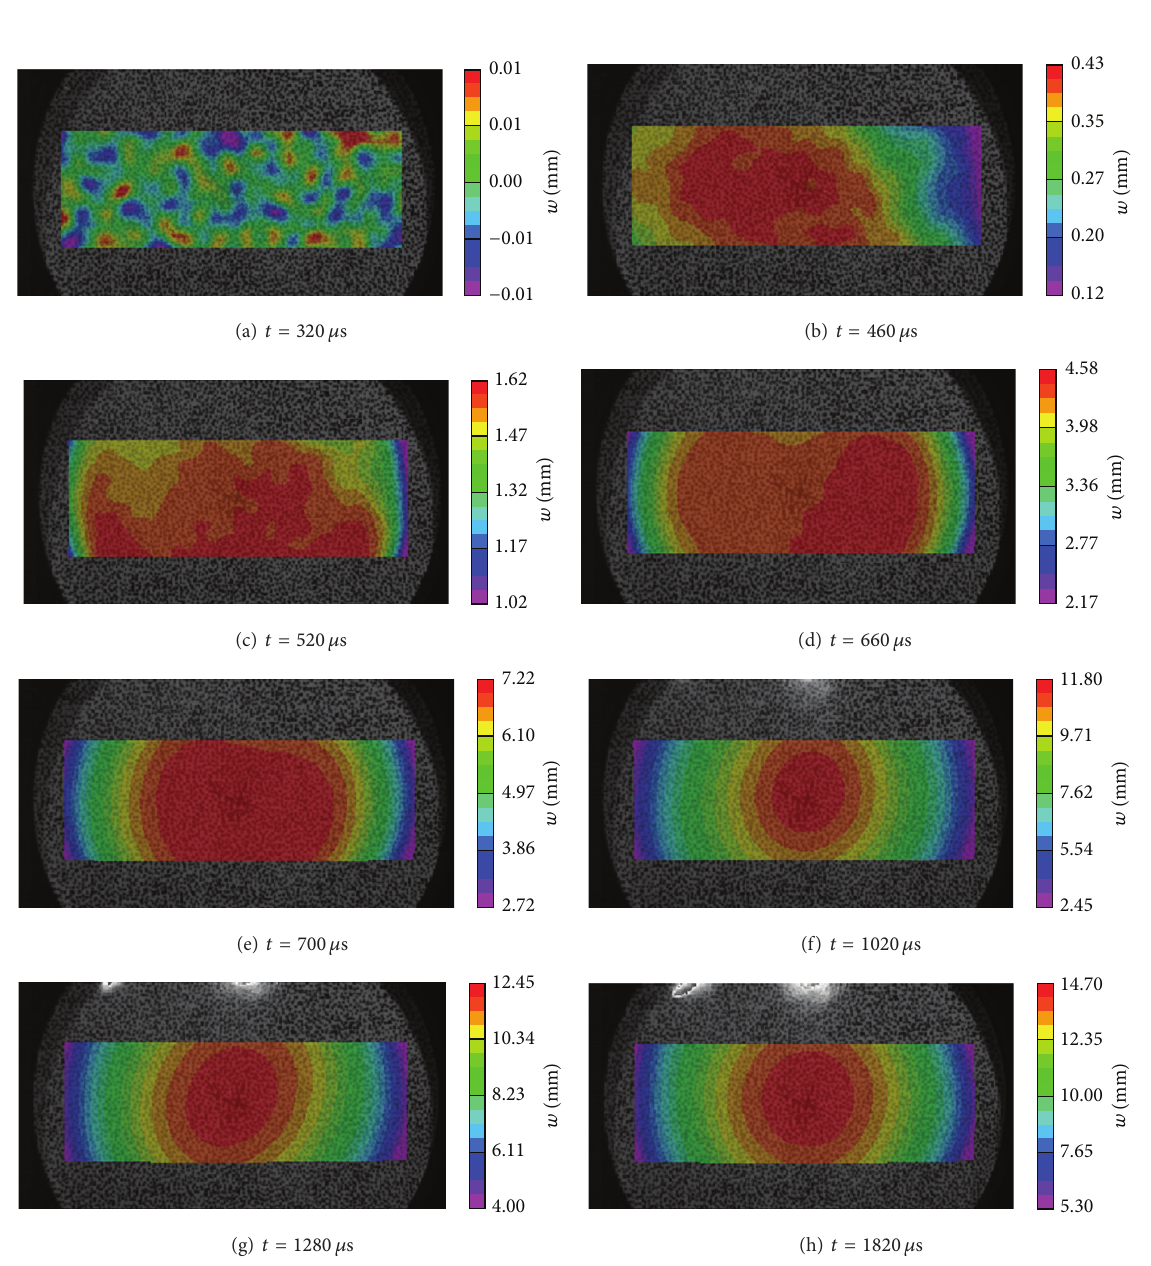
Figure 6: Full-field resultant displacements at different time steps (mm) for aluminium honeycomb sandwich panel ( 𝑐 = 4.0 , 𝑉 0 = 77.0 m/s, = 20.47 MPa, 𝜃 = 26.8 𝜇 s, and ̂ 𝐼 = 0.630 𝑝 𝑚𝑠 0